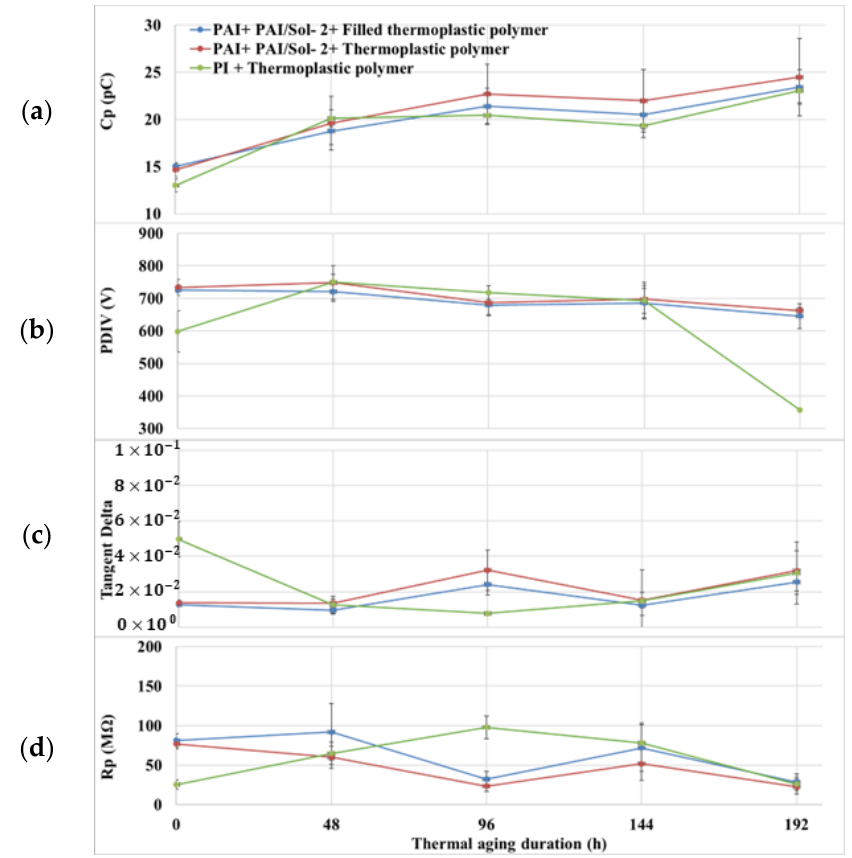
Figure 11. Mean values of dielectric parameters collected during the thermal aging test at 300 ◦ C: ( a ) Parallel capacitance (Cp). ( b ) Partial discharge inception voltage (PDIV). ( c ) Dielectric loss factor (tangent delta). ( d ) Parallel resistance